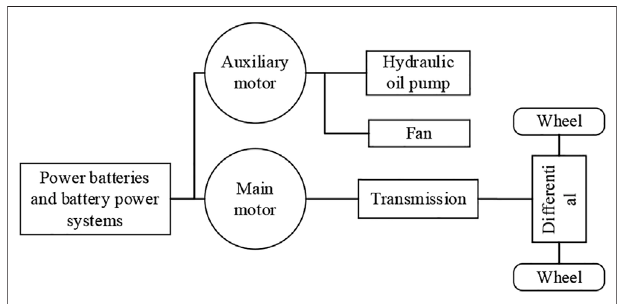
FIGURE 1 | Block diagram of the main and auxiliary motor drive modes.